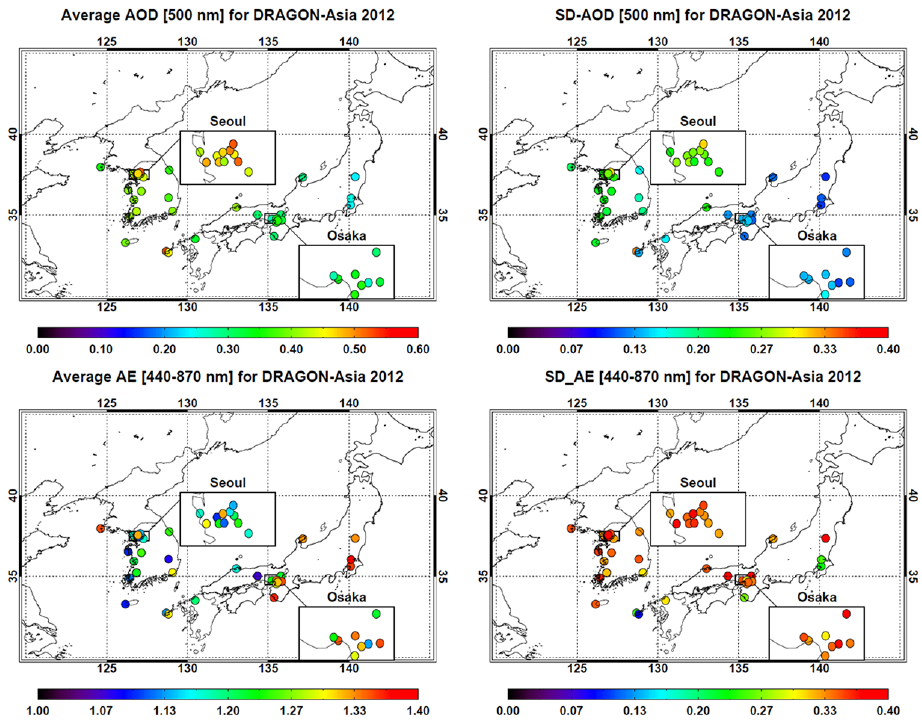
Figure 2. The (a, c) average and (b, d) standard deviation (1 σ) of (a, b) AOD at 500nm and (c, d) Ångström exponent between 440 and 870nm during DRAGON-NE Asia 2012 campaign for each